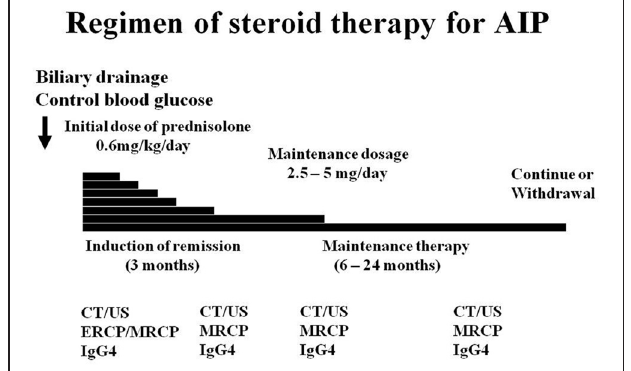
FIGURE 2 | Regimen of Japanese standardsteroidtreatmentfor